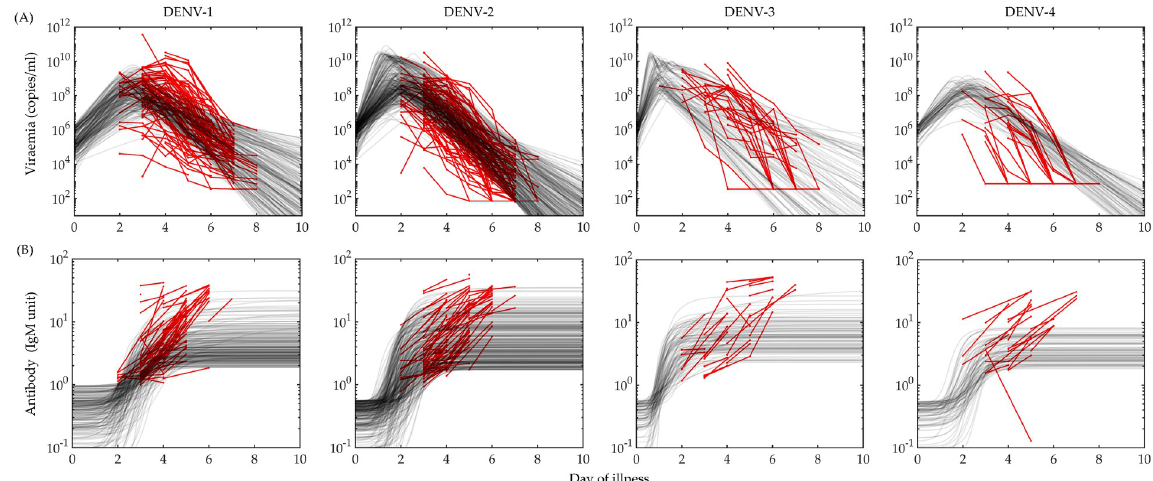
Fig 2. Population of models. The data of (A) viraemia and (B) antibody response for 208 (78 for DENV-1, 83 for DENV-2, 25 for DENV-3 and 22 for DENV-4) hospitalised dengue patients reported in Nguyen et al [8] are calibrated to construct serotype specific population of models (POMs). The biomarker data are shown in red lines with dots and the calibrated models from the POMs are plotted in transparent black lines. The calibration is performed for the ranges of available data on each day of illness. The total number of calibrated models in the POMs is 701 (221 for DENV-1, 306 for DENV-2, 93 for DENV-3 and 81 for DENV-4). The level of viraemia on day zero of illness is covered with the heterogeneity generated by the viral load on the day of infection and the incubation period.